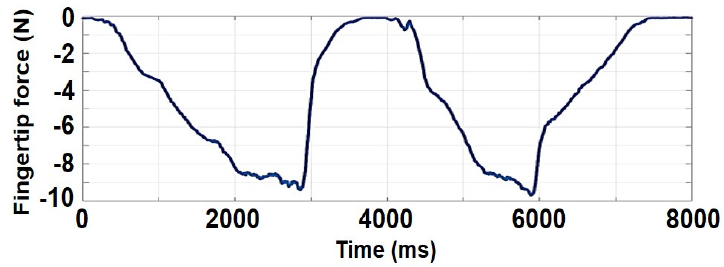
Figure 18. Grasping force of the fingertip.